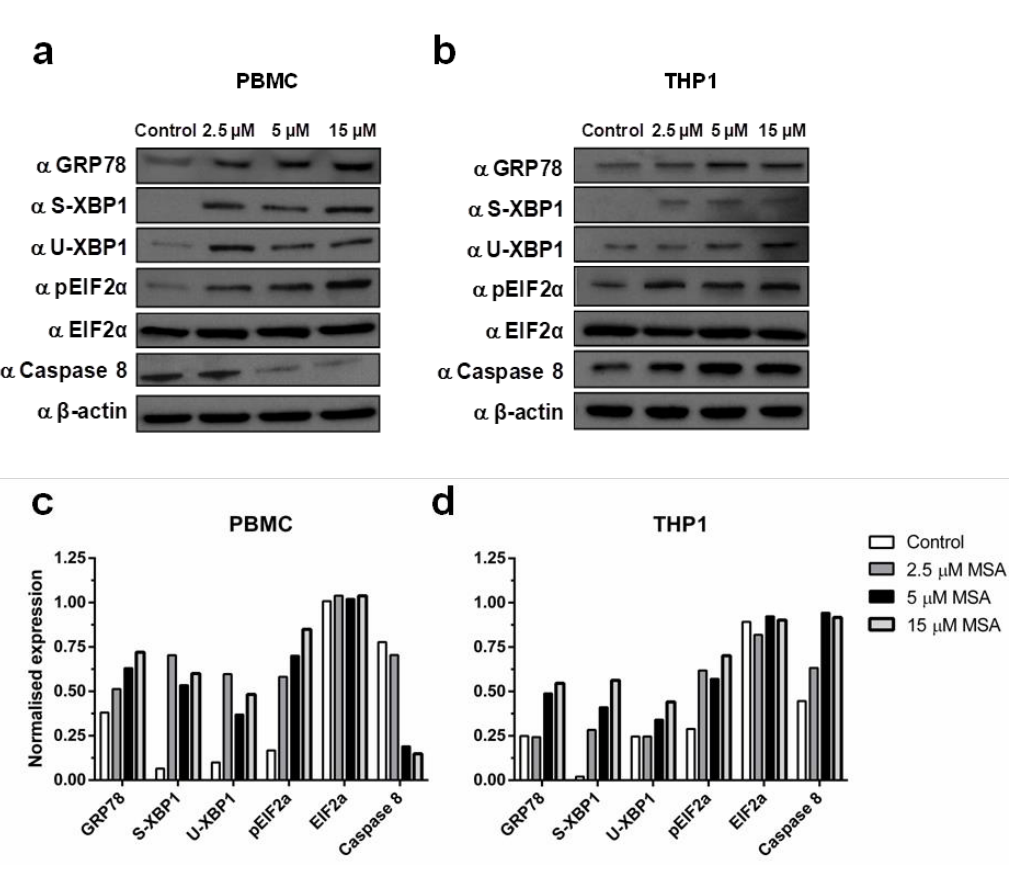
Figure 1. Selenium induces endoplasmic reticulum (ER) stress response in normal and malignant cells. ( a ) Concentration-dependent increase in ER stress proteins and decrease in caspase-8 in peripheral blood mononuclear cells (PBMCs) with 2.5, 5 and 15 µM methylseleninic acid (MSA) at 6 h; ( b ) Concentration-dependent increase in both ER stress proteins and caspase-8 in THP1 cells; ( c , d ) Quantification of protein expression in PBMC and THP1 cells.